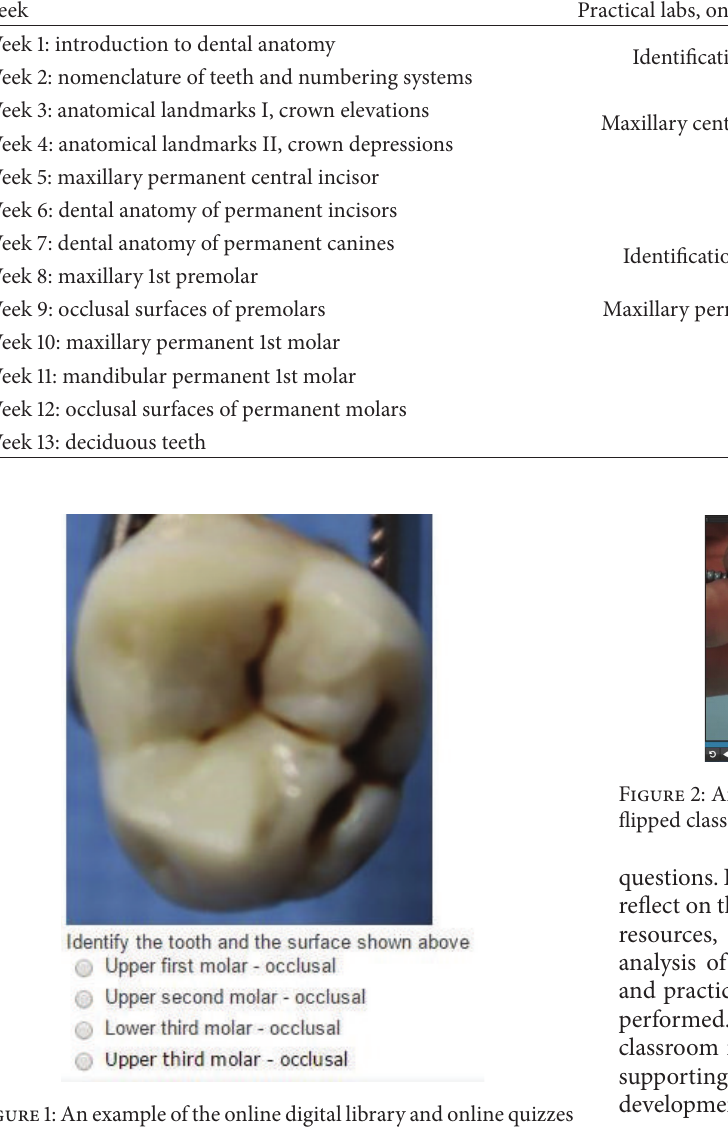
Figure 1: An example of the online digital library and online quizzes developedaspartoftheflippedclassroommethodusedinthisstudy.